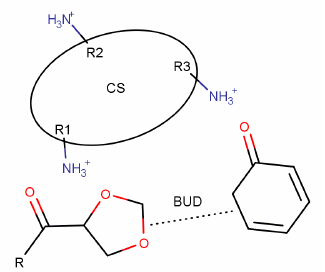
Figure 8. The configuration with the strongest interaction between Chitosan and Budesonide has two sites, one for each carbonyl oxygen atom of BUD. Each carbonyl oxygen interacts with the second nearest protonated amino group.